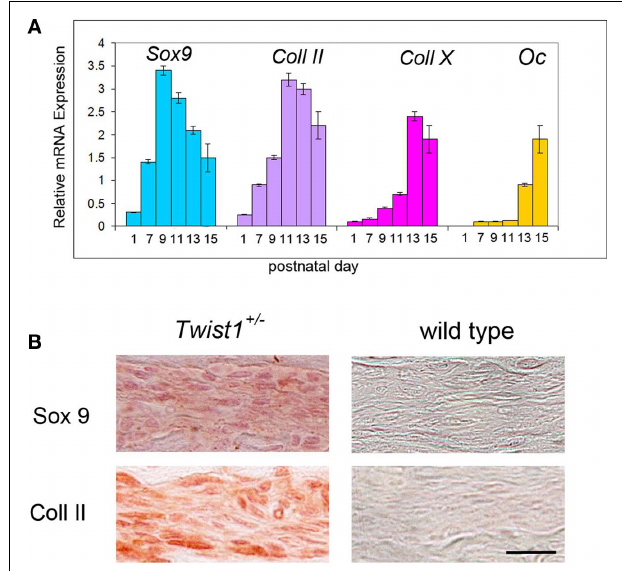
FIGURE 3 | Presence of specific chondrogenic markers in the differentiating COR suture mesenchyme. (A) Expression analysis of chondrogenic markers by qPCR showing a chondrogenic pattern of the differentiating COR suture mesenchyme in Twist1 + / − mice. By postnatal day 15 upregulation of osteocalcin (Oc) is observed, as result of the COR suture closure. (B) Immunohistochemistry for Sox9 and Col II confirm cartilage tissue formation in the COR suture of Twist1 + / − at day p11. Scale bar: 10 μ m